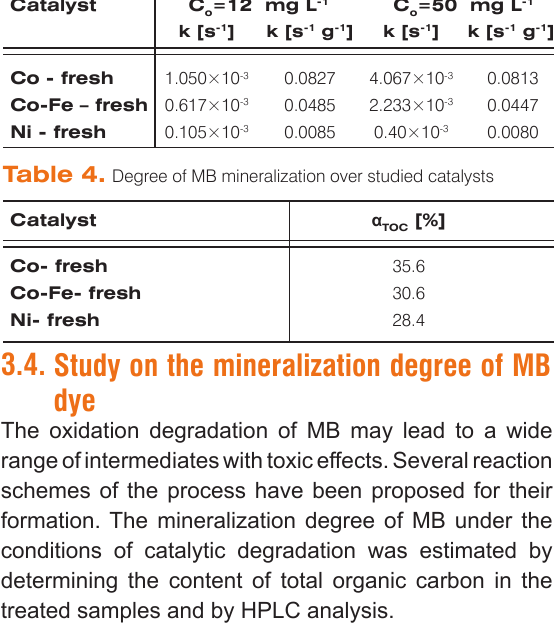
Table 3. First-order rate constants for the MB oxidation process